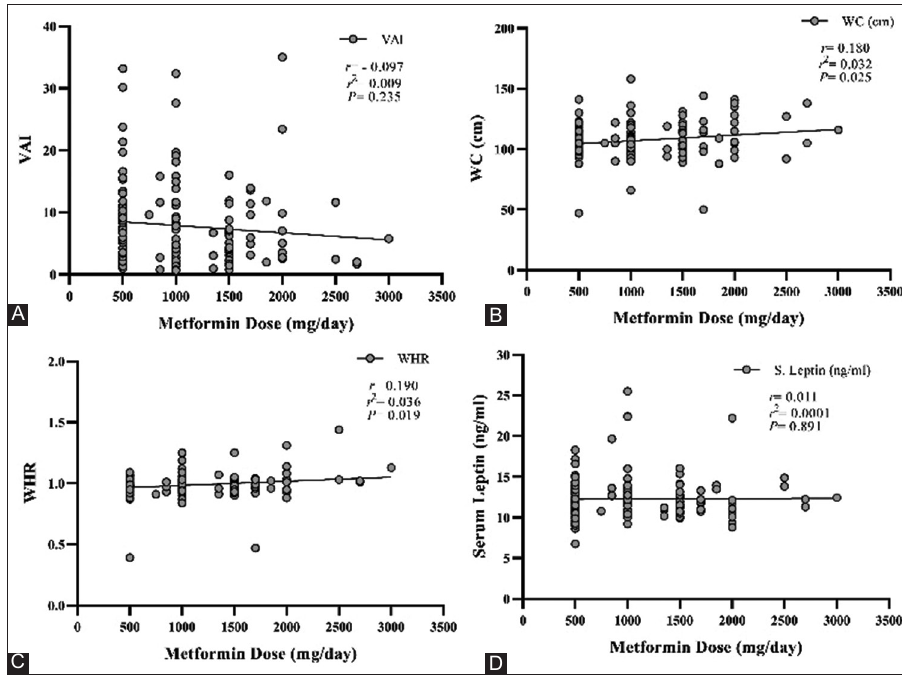
FIGURE 2. Correlation of metformin dose up‑titration with (A) VAI, (B) WC, (C) WHR, and serum leptin levels (D) of Iraqi patients with